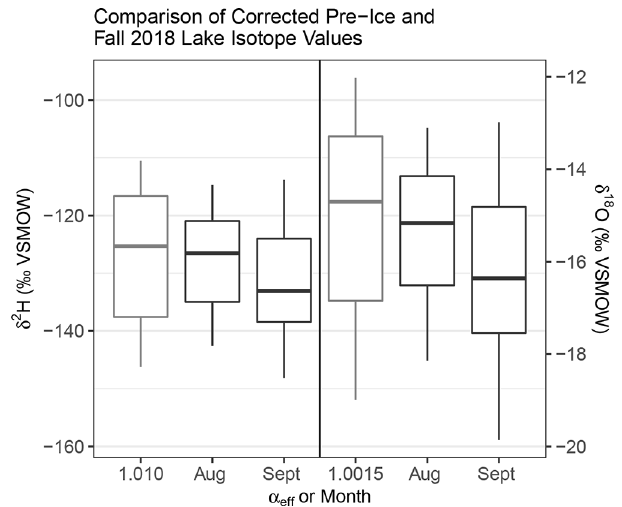
Figure C1. Comparison of pre-lake ice formation and Au- gust/September 2018 isotopic composition of lake waters. The α eff values ( δ 2 H α eff = 1 . 010, δ 18 O α eff = 1 . 0015) match closely with the August and September 2018 isotopic composition of lake wa- ters. This suggests that these α eff estimates are appropriate to use for estimating the pre-ice formation isotopic composition of lake